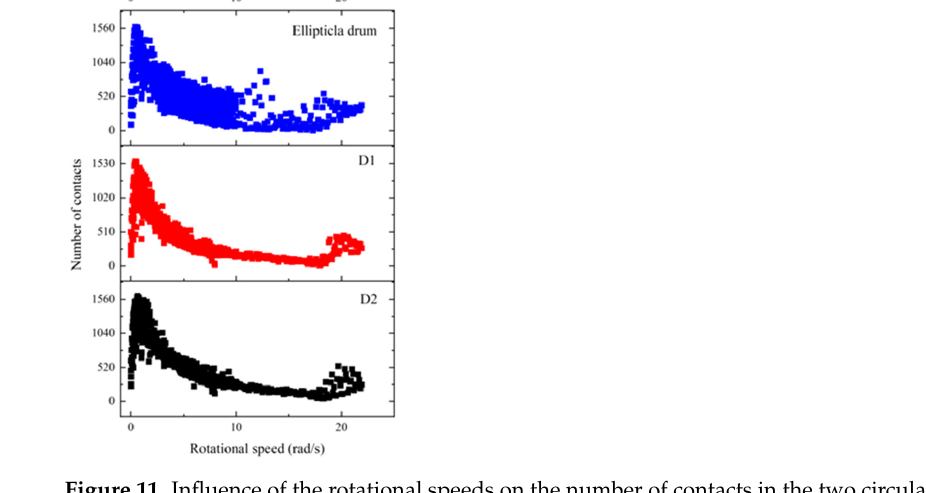
Figure 11. Influence of the rotational speeds on the number of contacts in the two circular drums and the elliptical drum.